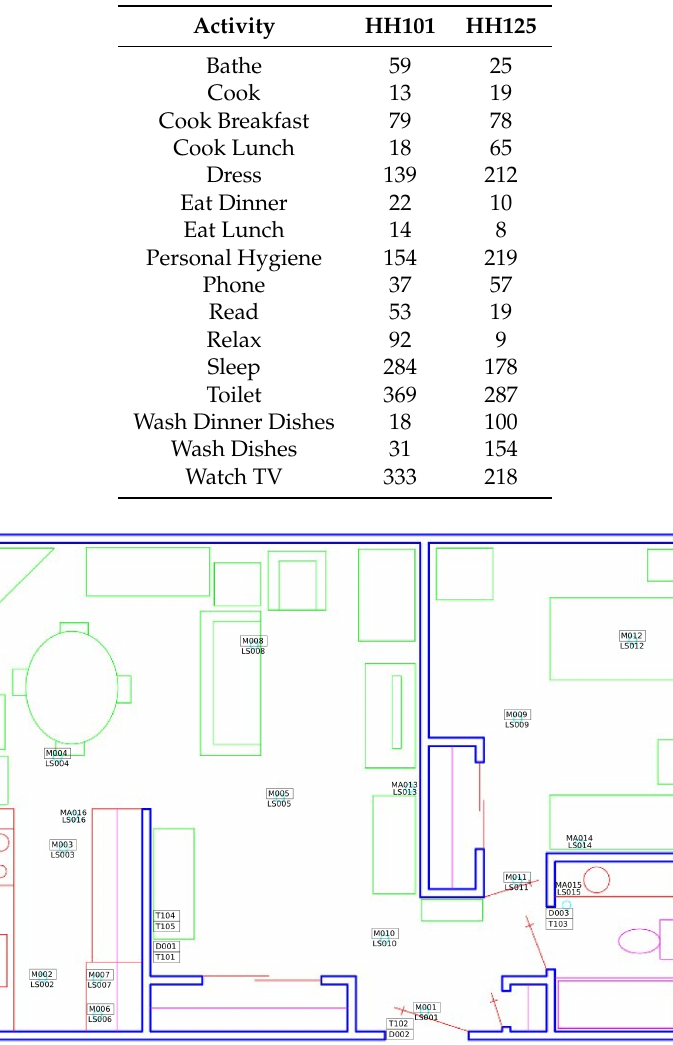
Table 4. Count of activities in HH101 and HH125 smarthomes.